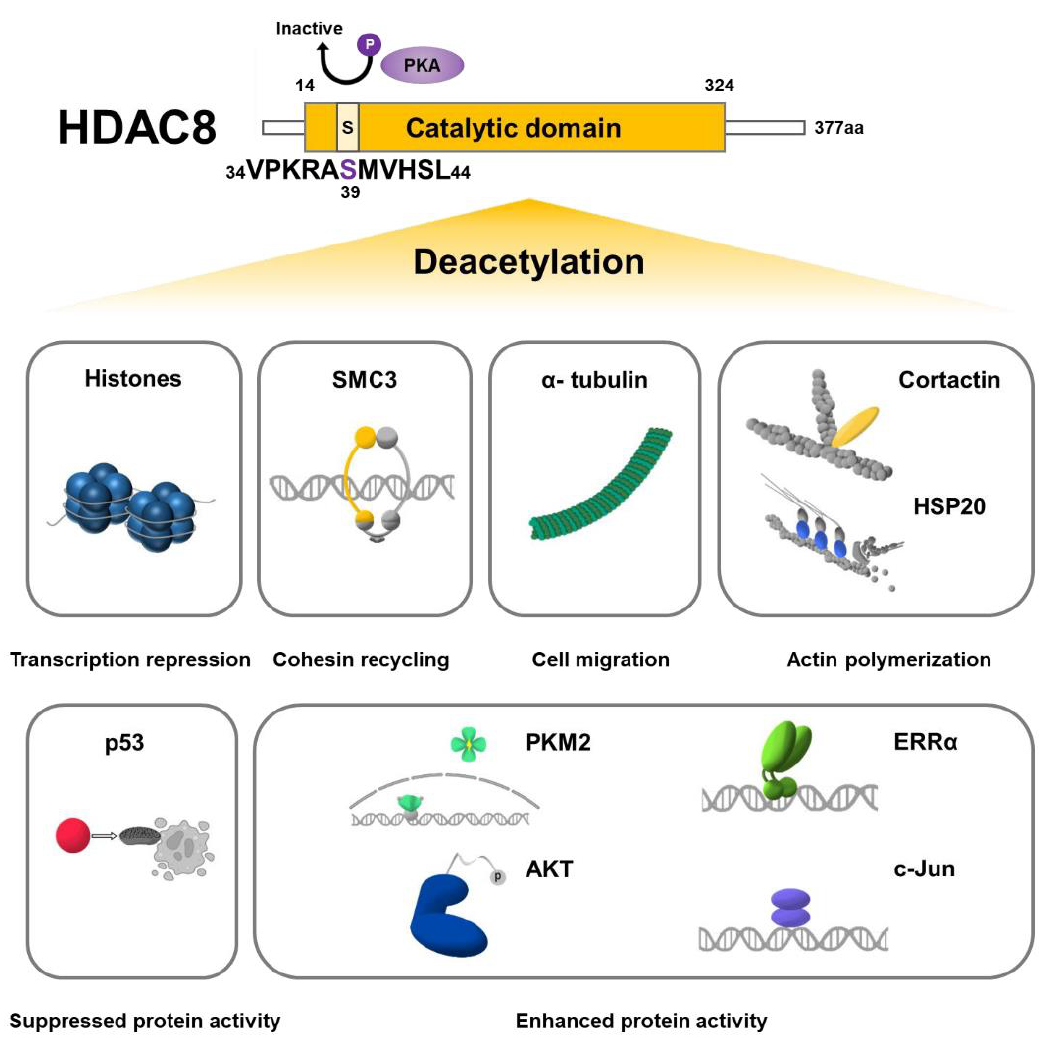
Figure 3. Schematic representation of histone and non-histone substrates of HDAC8. HDAC8 deacetylates histones and suppresses transcription of target genes. HDAC8 also deacetylates non- histone substrates such as SMC3, α -tu bulin, cortactin, HSP20, p53, PKM2, AKT, ERRα , and c-Jun.